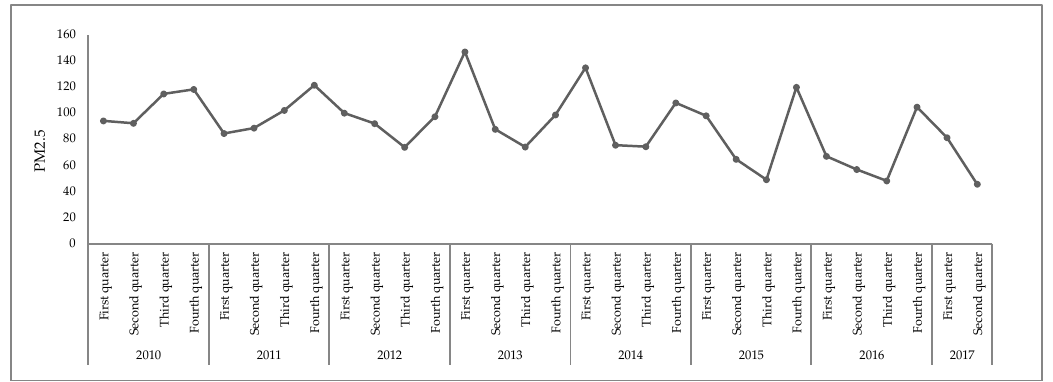
Figure 2. The quarterly variation trends of PM 2.5 during 2010 – 2017.